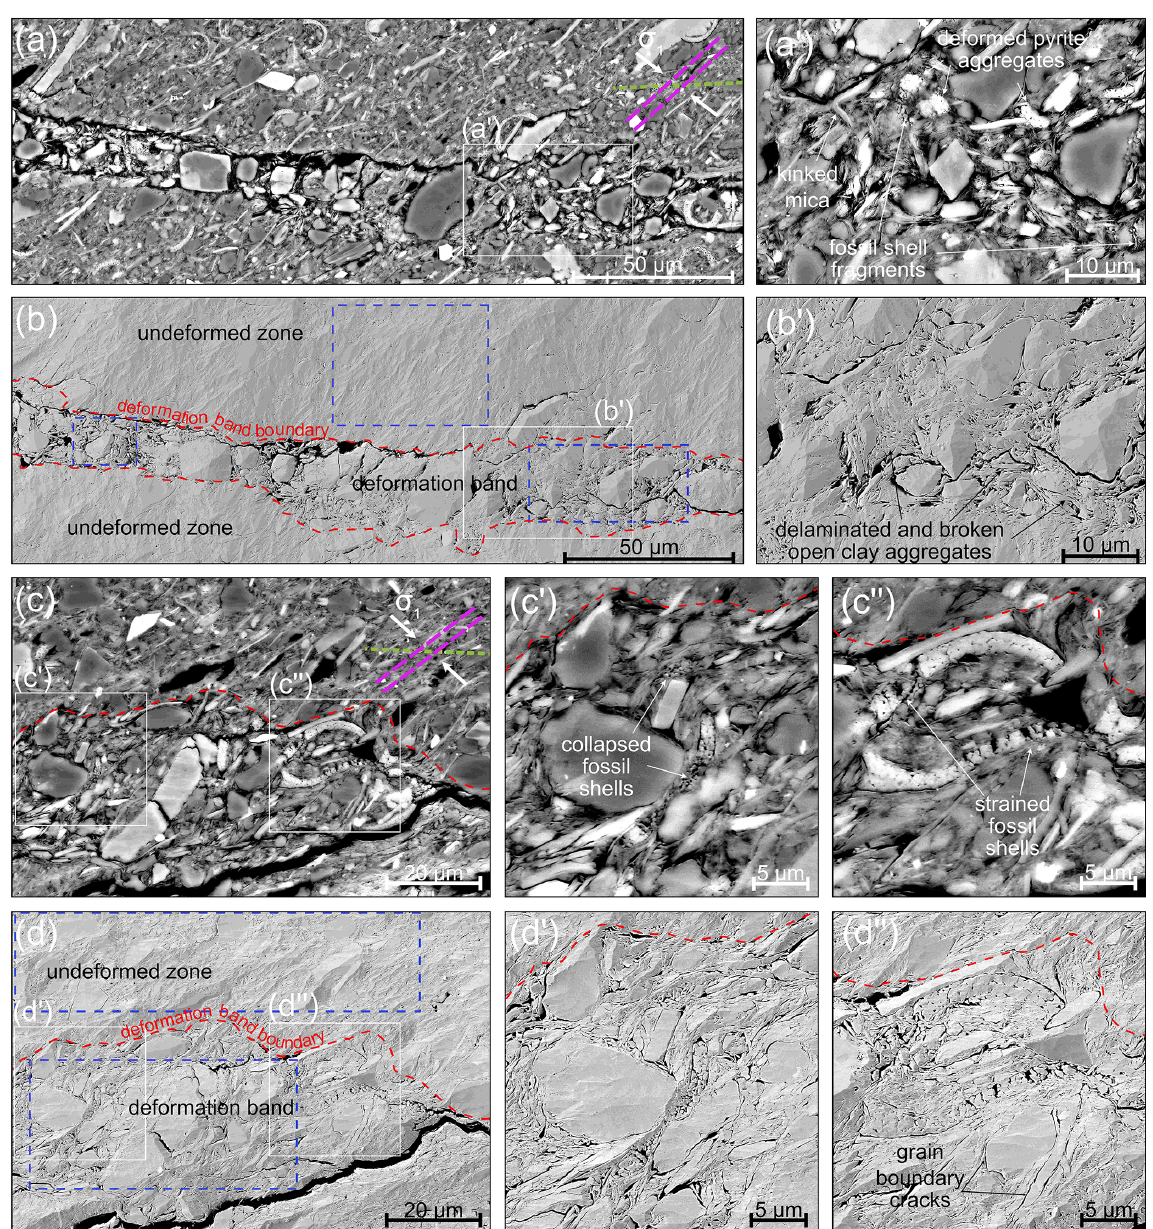
Figure 7. BIB–SEM micrographs showing a zone of increased porosity. Panels (a, a’) and (c, c’ ,c”) are BSE images indicating the grain structures within the dilatation band of up to 25µm thickness. The detailed micrograph (a’) shows typical strain indicators such as kinked mica, deformed pyrite aggregates, and remnants of fossil shells. Panels (b) and (b’) are SE2 images showing the pore structure with consider- ably increased porosity along and within the deformation band, as well as the delamination of clay aggregates at higher magnification. Panels (c) and (c’, c”) present intragranular fractures and strained as well as collapsed and disintegrated fossil shells. The SE2 image (d) shows an increased number of fractures within the deformation band, as well as increased pore space between disintegrated shell fragments and clay aggregates (d’) . Panel (d”) displays grain boundary fractures, which appear as porous rims around quartz grains. Blue boxes indicate the locations where porosity has been